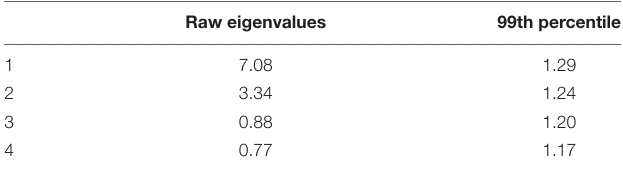
TABLE 2 | Results of the parallel analysis.